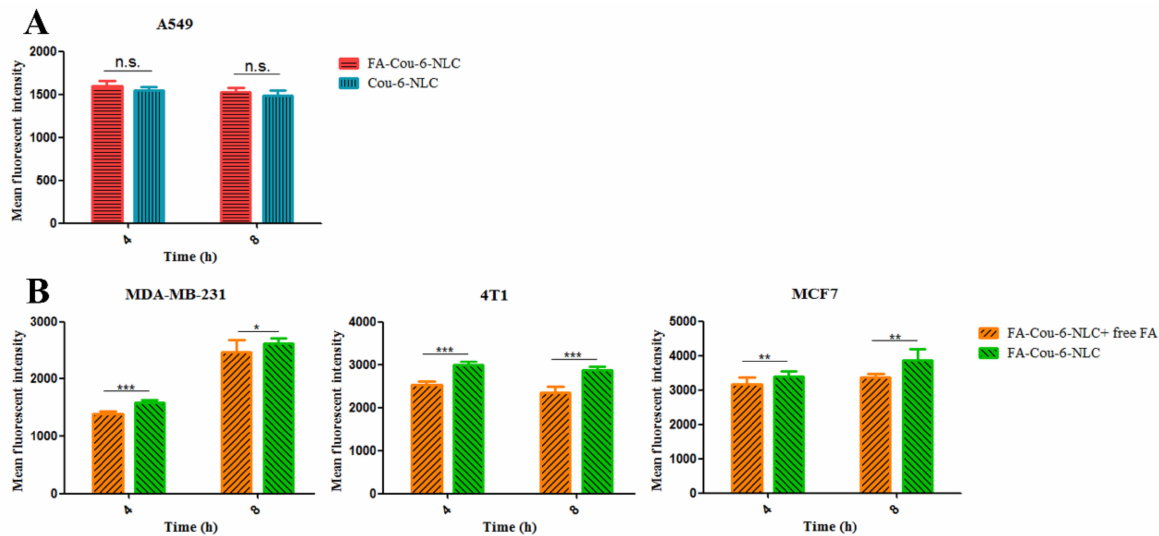
Figure 4. ( A ) The cellular fluorescence intensity of Cou-6-NLC and FA modified Cou-6-NLC at different incubation time intervals (4 h, 8 h) in A549 cells. ( B ) Blocking experiment after pretreatment with excess FA. * p < 0.05; ** p < 0.01; *** p < 0.001; n.s., not significant. Results are expressed as mean ± SD, n = 3.